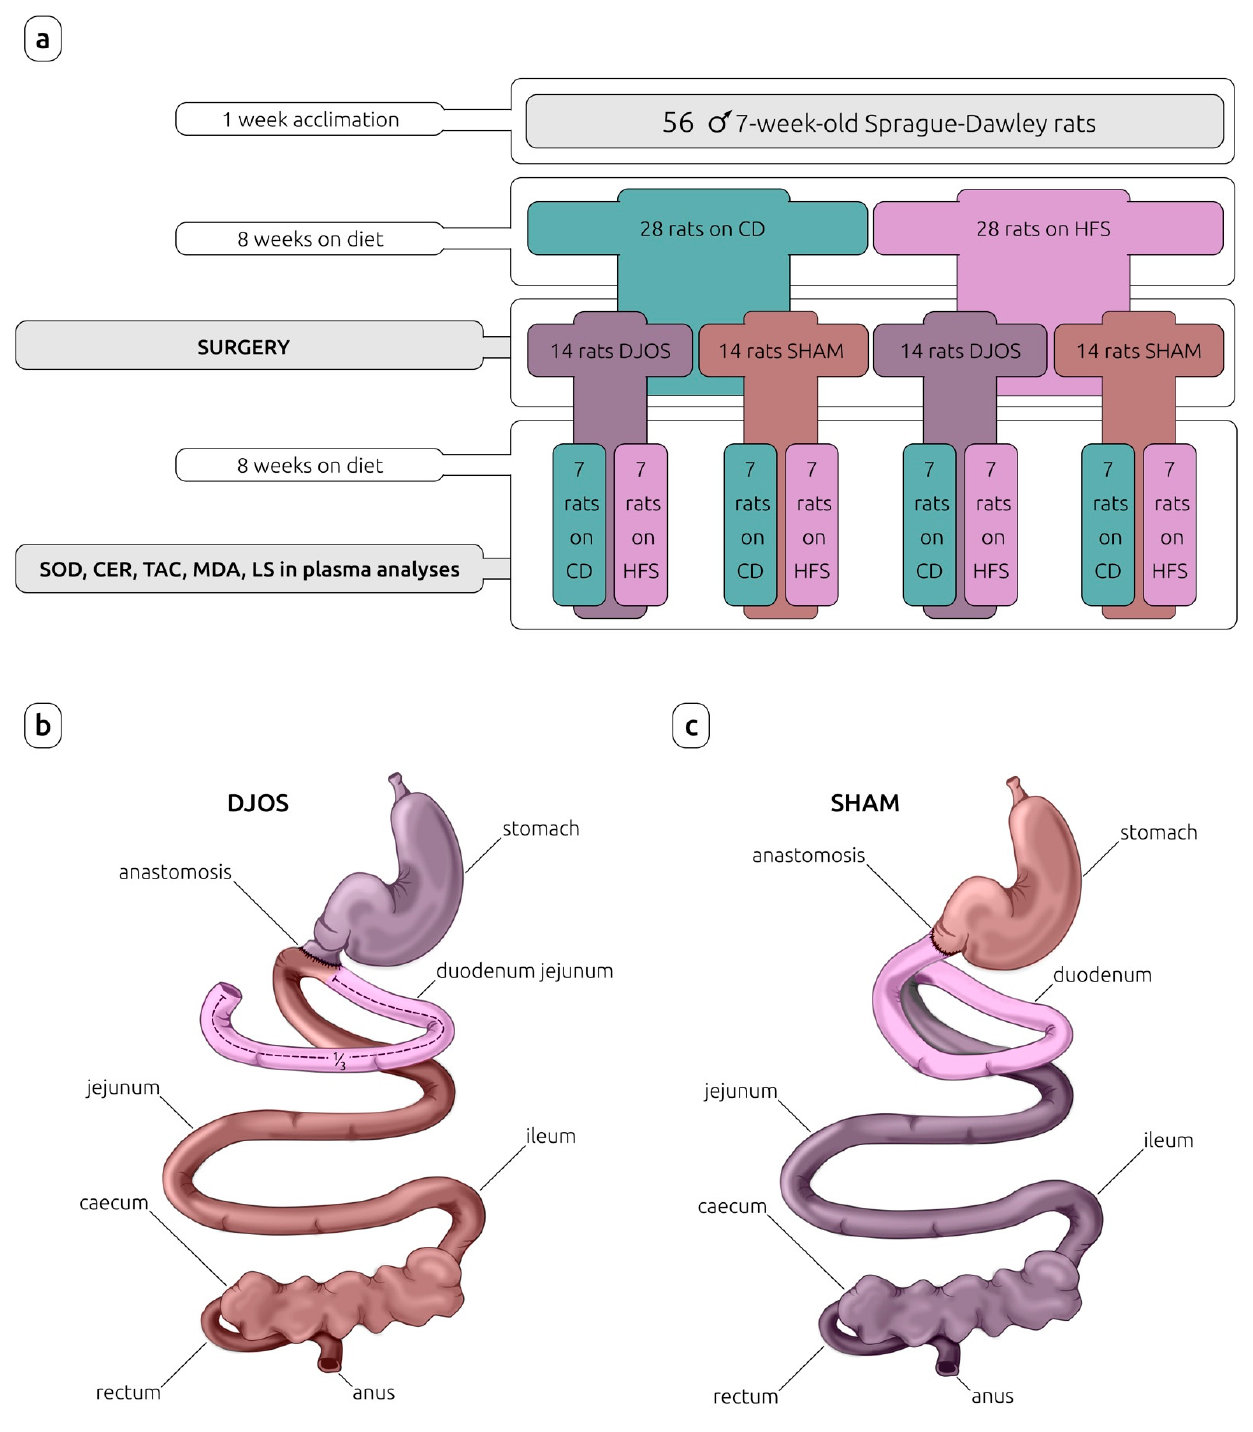
Figure 1. Study design ( a ) and surgeries performed on Sprague-Dawley rats subjected to ( b ) duo- denojejunal omega switch (DJOS) and ( c ) control (SHAM) surgery. Legend: CD—control diet, CER—ceruloplasmin activity, HFS—high-fat/high-sugar diet, LS—lipofuscin concentration, MDA—malondialdehyde concentration, SOD—superoxide dismutase activity, TAC—total antioxidant capacity.